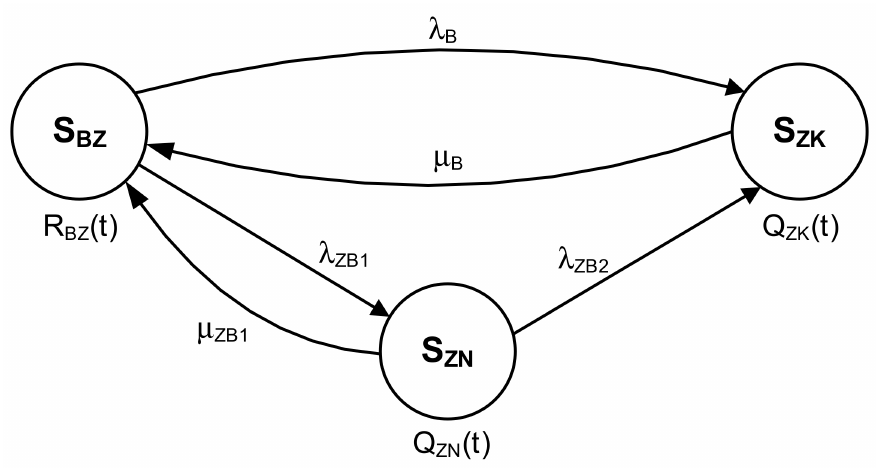
Figure 1. Relations between the robot companion and the infrastructure related to communication